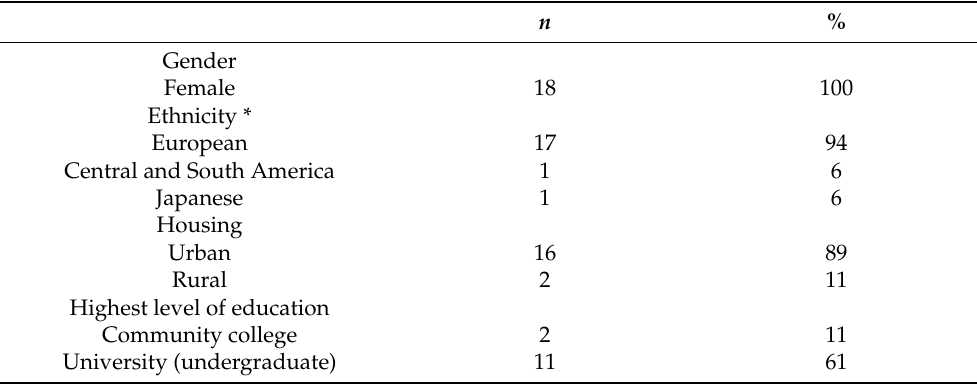
Table 2. Demographic, clinical, and health